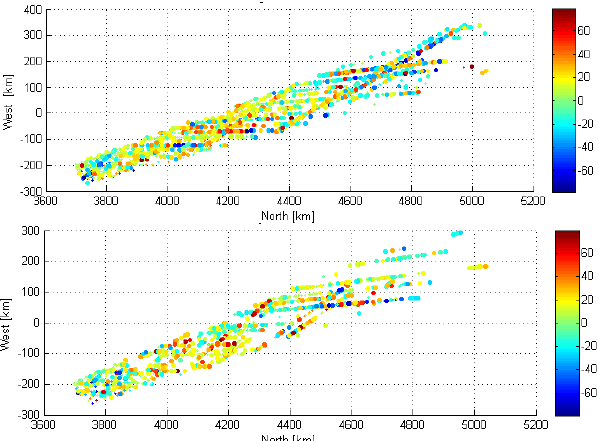
Figure 5. Plots of estimated elevation change rates (in cm/y) over the whole ROI. In the upper and lower plots the results obtained from ‘Spr’ and ‘Aut’ campaigns are shown, respectively. Colours of different points represent the estimated average velocity, according to the scale in colorbars on the right.